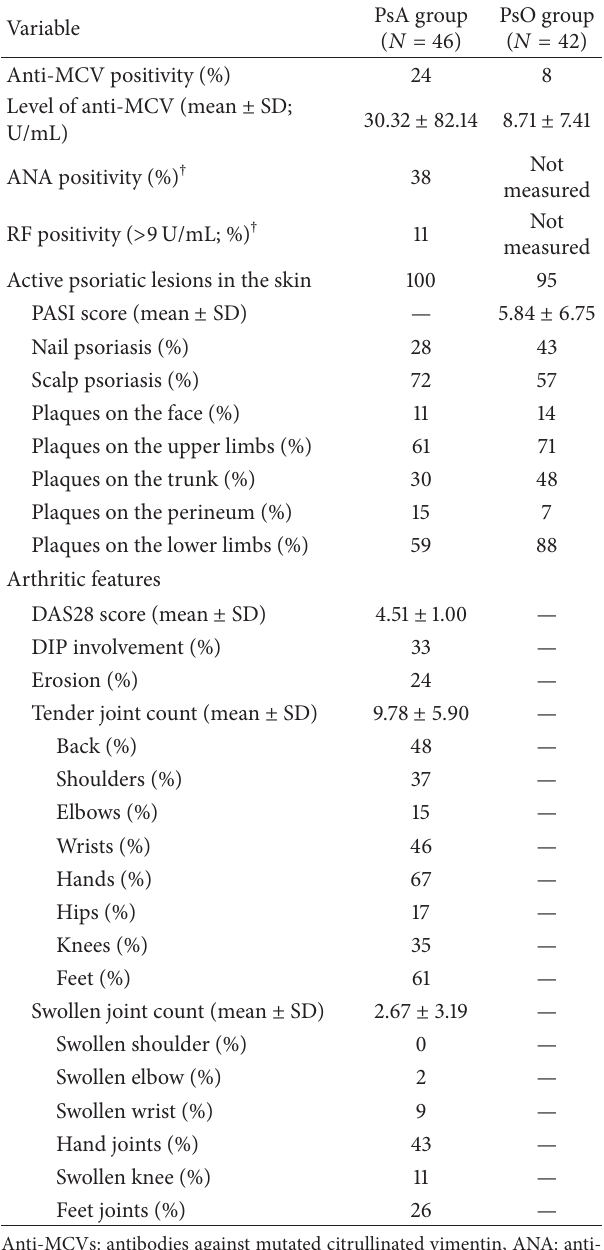
Table 2: Clinical and laboratory characteristics of patients in the psoriatic arthritis (PsA) and psoriasis vulgaris (PsO)